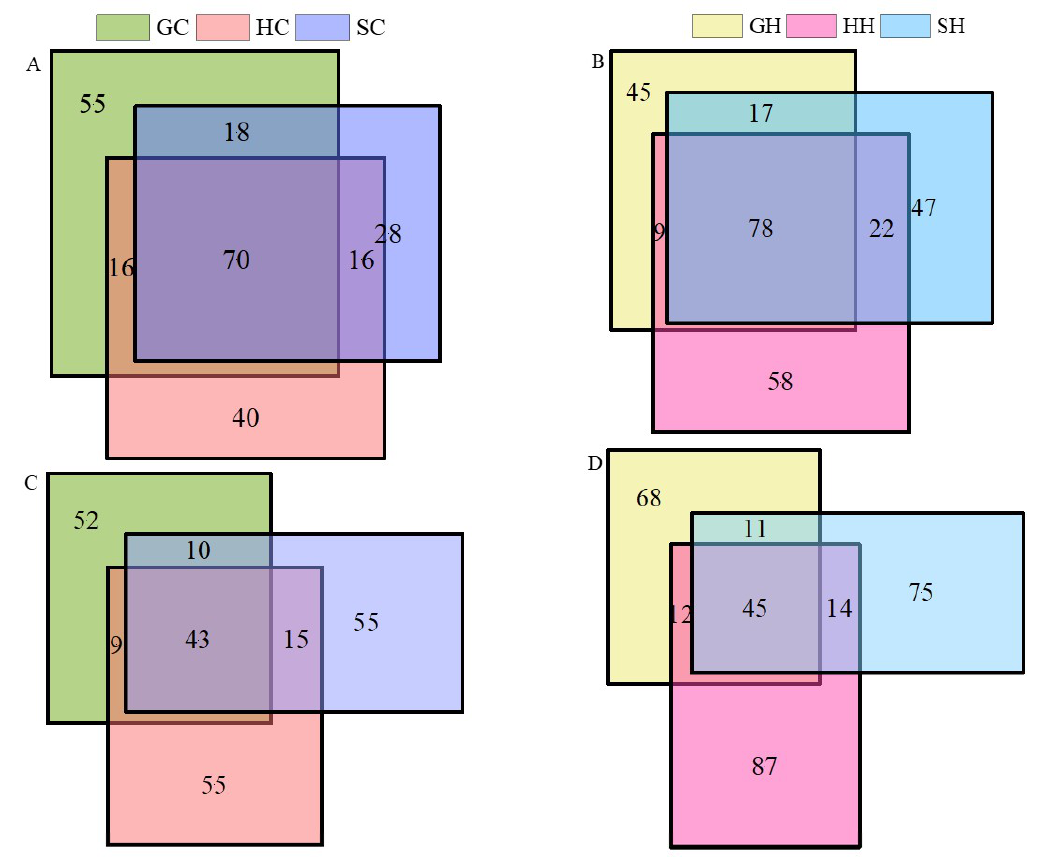
Figure 2. The Venn diagram shows common or unique OTUs number in the different treatments in three soils with different pH. Figure ( A,B ) shows the changes in bacterial OTUs before and after the addition of exogenous mercury, respectively, and Figure ( C,D ) shows the changes in fungal OTUs affected by mercury.